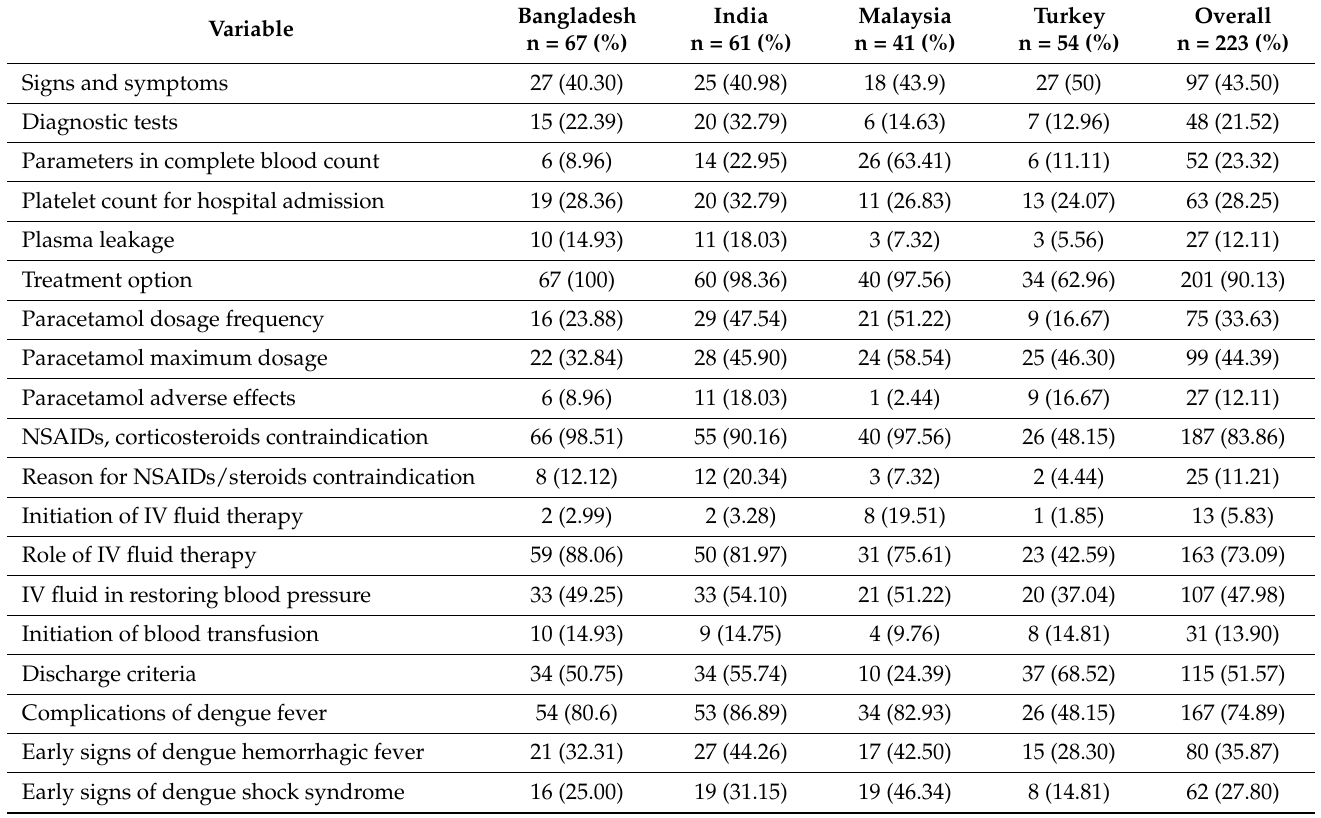
Table 2. Physician’s percentage of correct responses by country of